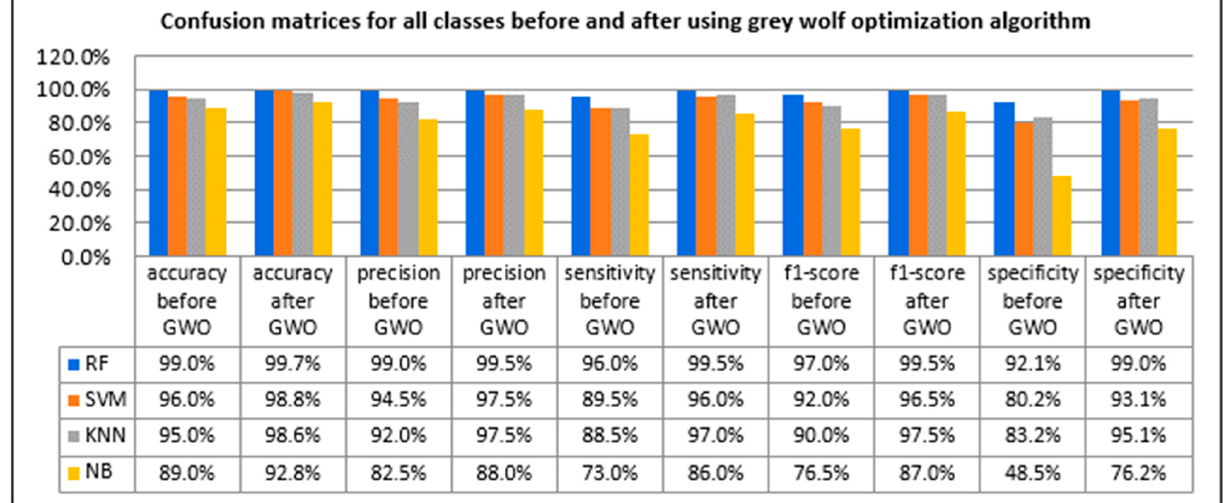
Figure 14 . Confusion matrices before and after using grey wolf optimization algorithm. Figure 14. Confusion matrices before and after using grey wolf optimization